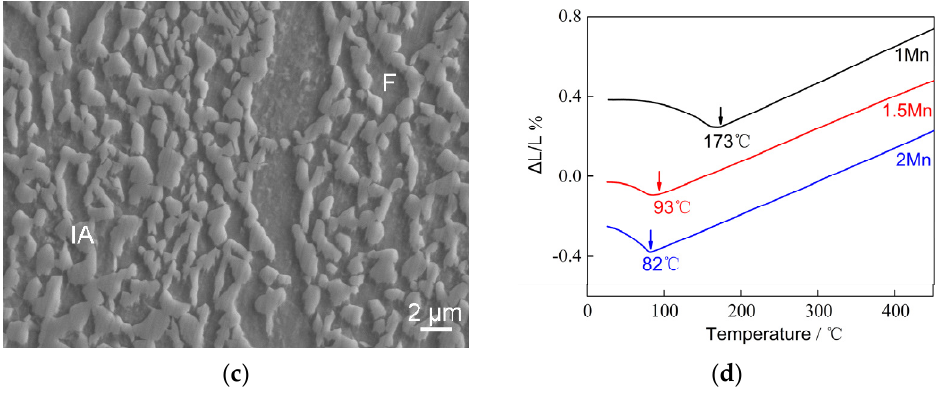
Figure 2. The quenched microstructure after intercritical annealing of ( a ) 1 Mn steel, ( b ) 1.5 Mn steel, and ( c ) 2 Mn steel; ( d ) relative volume variation as a function of temperature during cooling in process 1. F and IA present ferrite and prior austenite, respectively. Table 2. Fraction and grain size of prior austenite measured by image analyses.